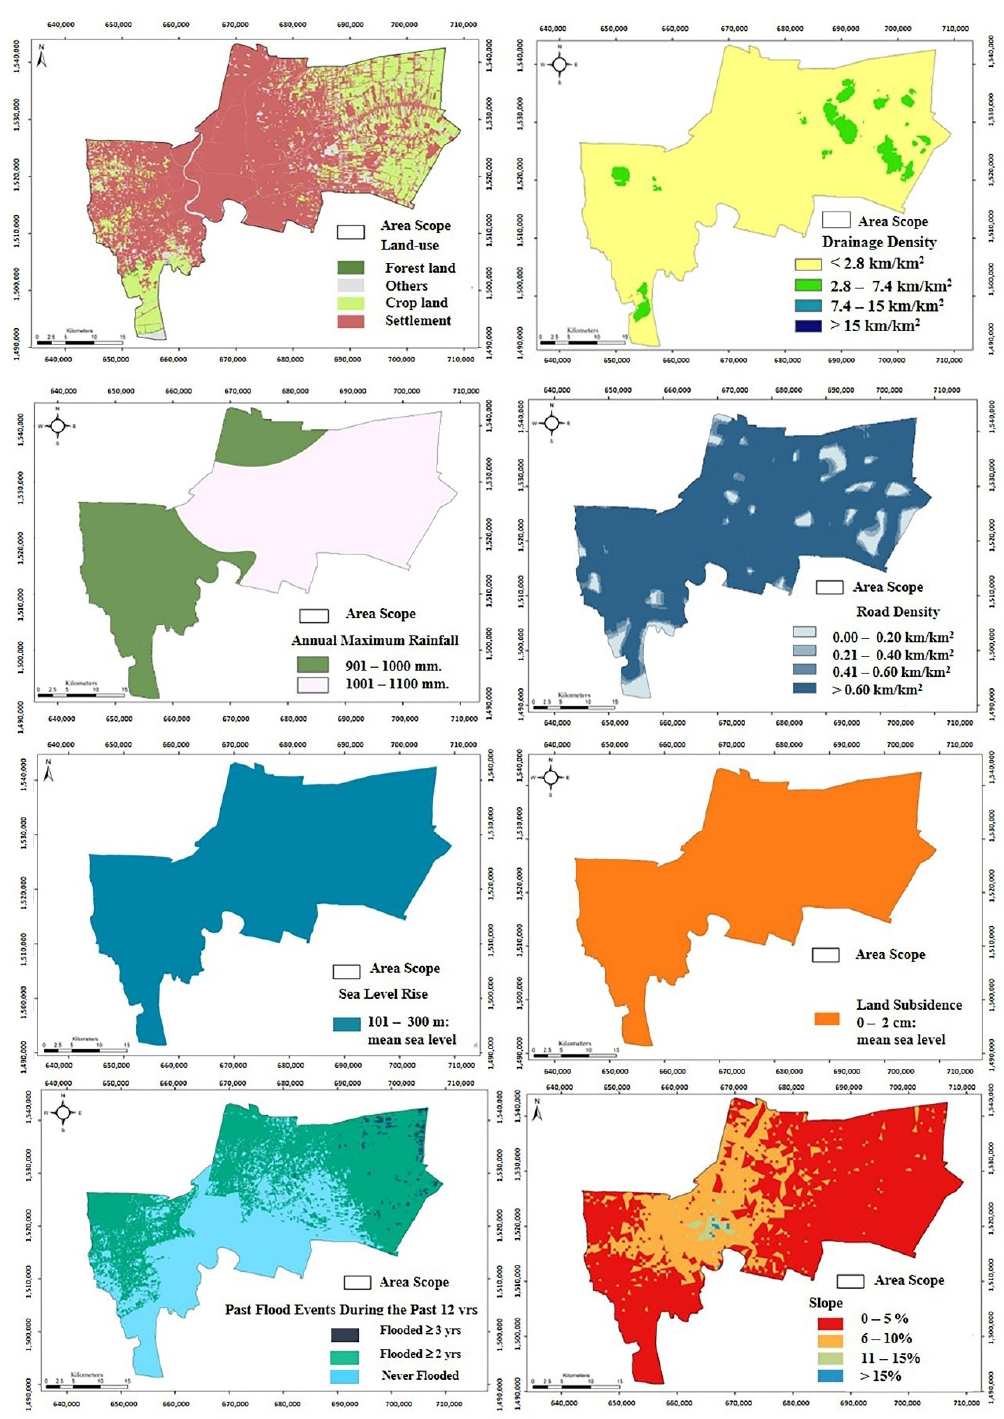
Figure 2. Eight thematic layer factors used for flood hazard analysis in Bangkok,